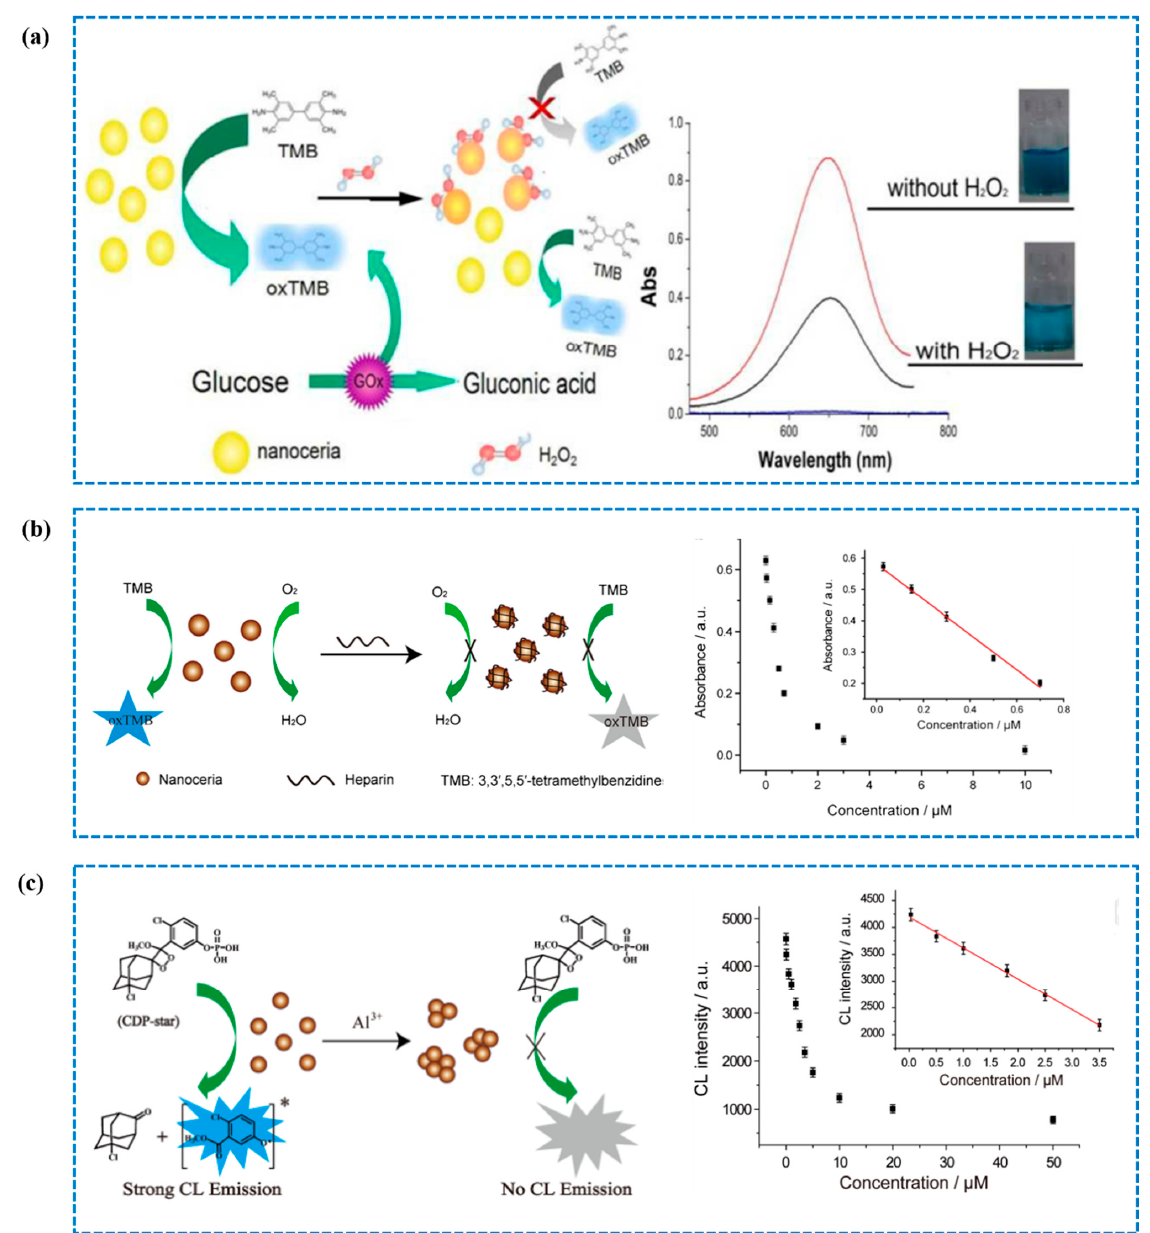
Figure 2. Application of nanoscale cerium oxide in detection of organ/inorganic molecules. ( a ) Detection of hydrogen peroxide and glucose [20] Copyright 2016 RSC Publishing.; ( b ) heparin detection [19] Copyright 2016 Springer Nature.; ( c ) metal ion detection [22]. Copyright 2019 Elsevier.